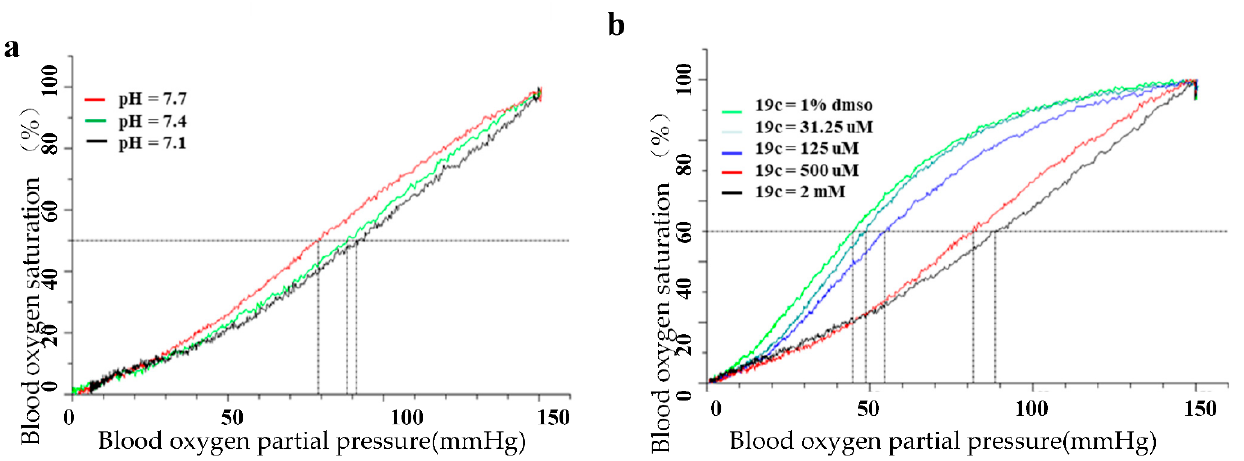
Figure 4. Evaluation of allosteric modifying property of target compound. ( a ) Bohr effect of allosteric modifying agent 19c at a concentration of 2 mM. ( b ) The oxygen dissociation curve (ODC) in the presence of different concentrations of allosteric modifying agent 19c